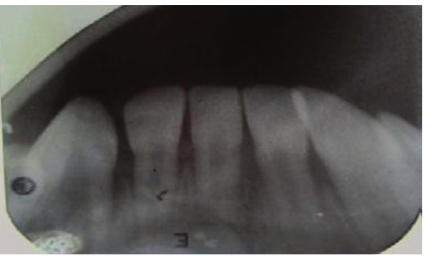
Figure 10: Postoperative IOPA of 73–83 region after 3 weeks with well-aligned 71 and